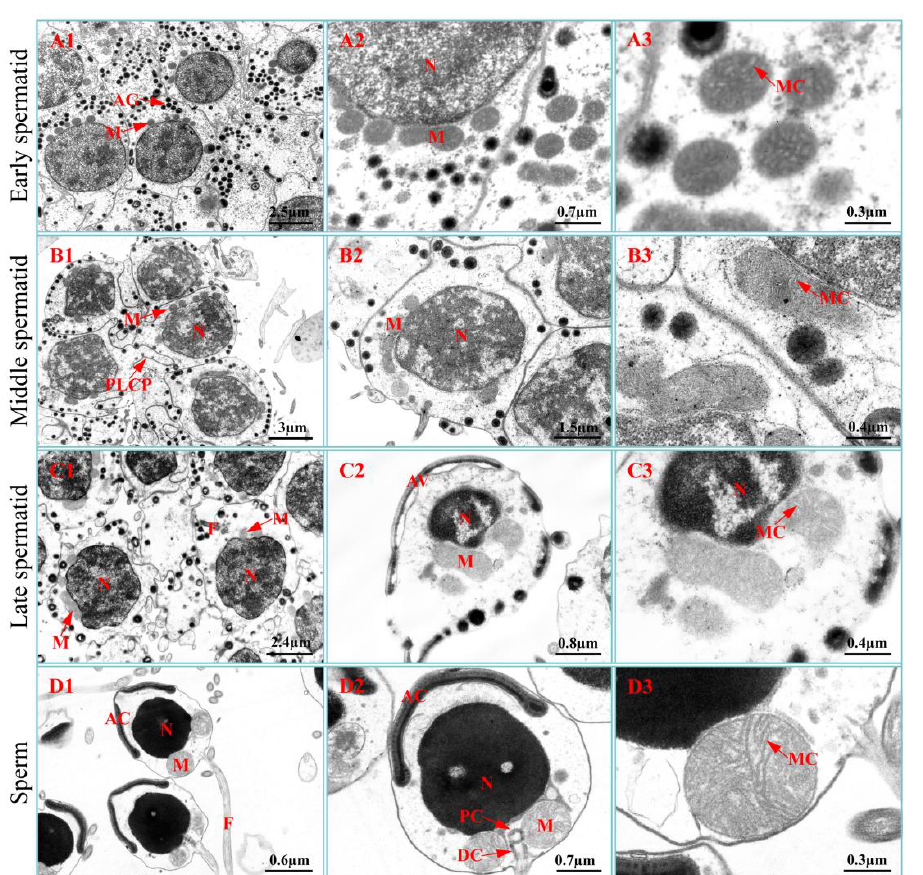
Figure 1. Ultrastructure of spermiogenesis. ( A1 – A3 ) Early spermatid, ( B1 – B3 ) middle spermatid, ( C1 – C3 ) late spermatid, and ( D1 – D3 ) sperm. AC: acrosome, AG: acrosomal granule, DC: distal centriole, F: flagellum, M: mitochondrion, MC: mitochondrial cristae, N: nucleus, PC: proximal centriole, PLCP: pseudopodia-like cytoplasmic protrusion.